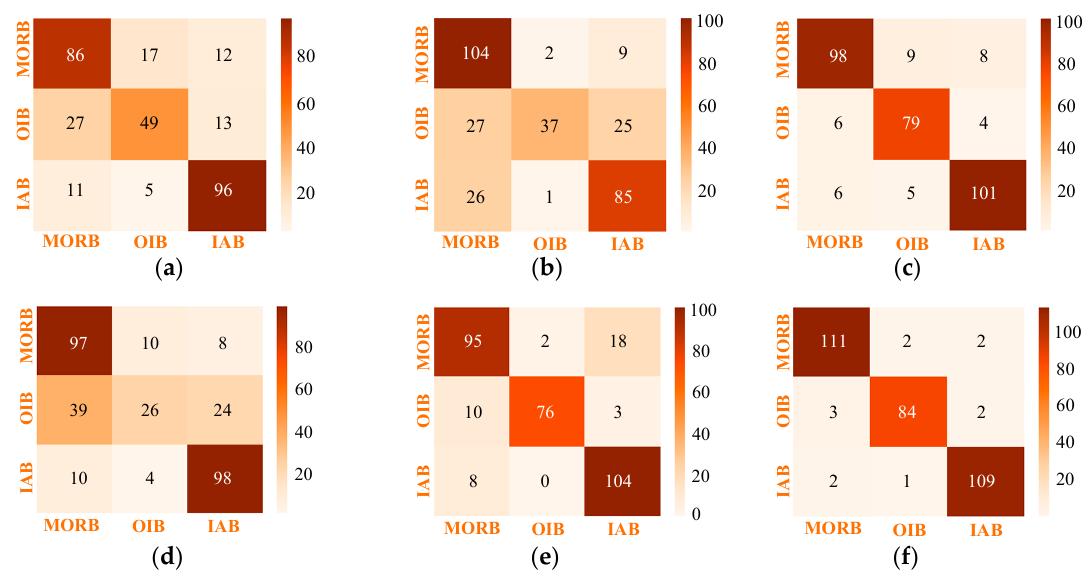
Figure 7. Confusion matrix visualization of tectonic discrimination of basalts in dataset 2 based on different MLAs: ( a ) logistic regression classifier (LRC); ( b ) naïve Bayes (NB); ( c ) multilayer perceptron (MLP); ( d ) support vector machine (SVM); ( e ) random forest (RF) and ( f )